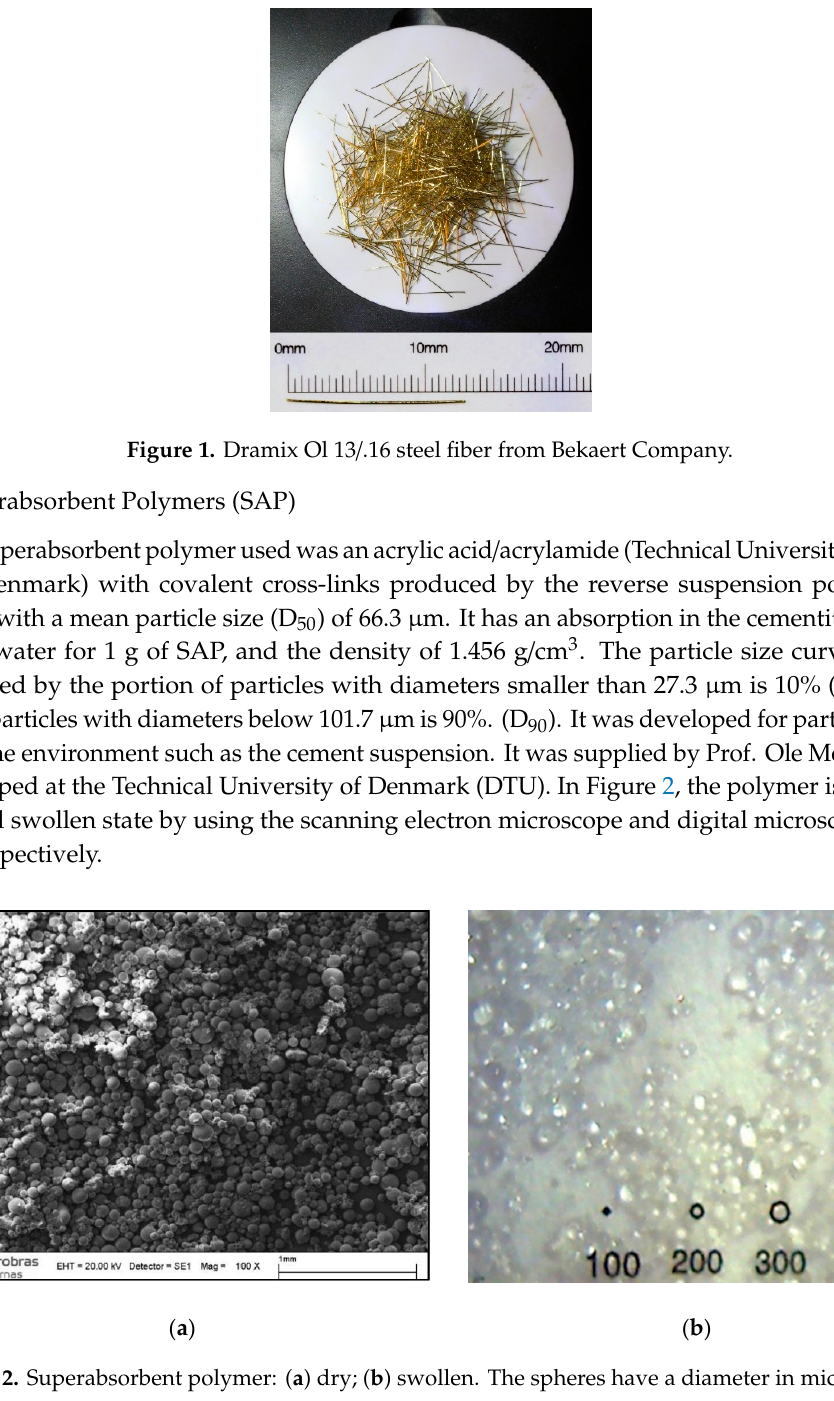
Figure 2. Superabsorbent polymer: ( a ) dry; ( b ) swollen. The spheres have a diameter in micrometers.